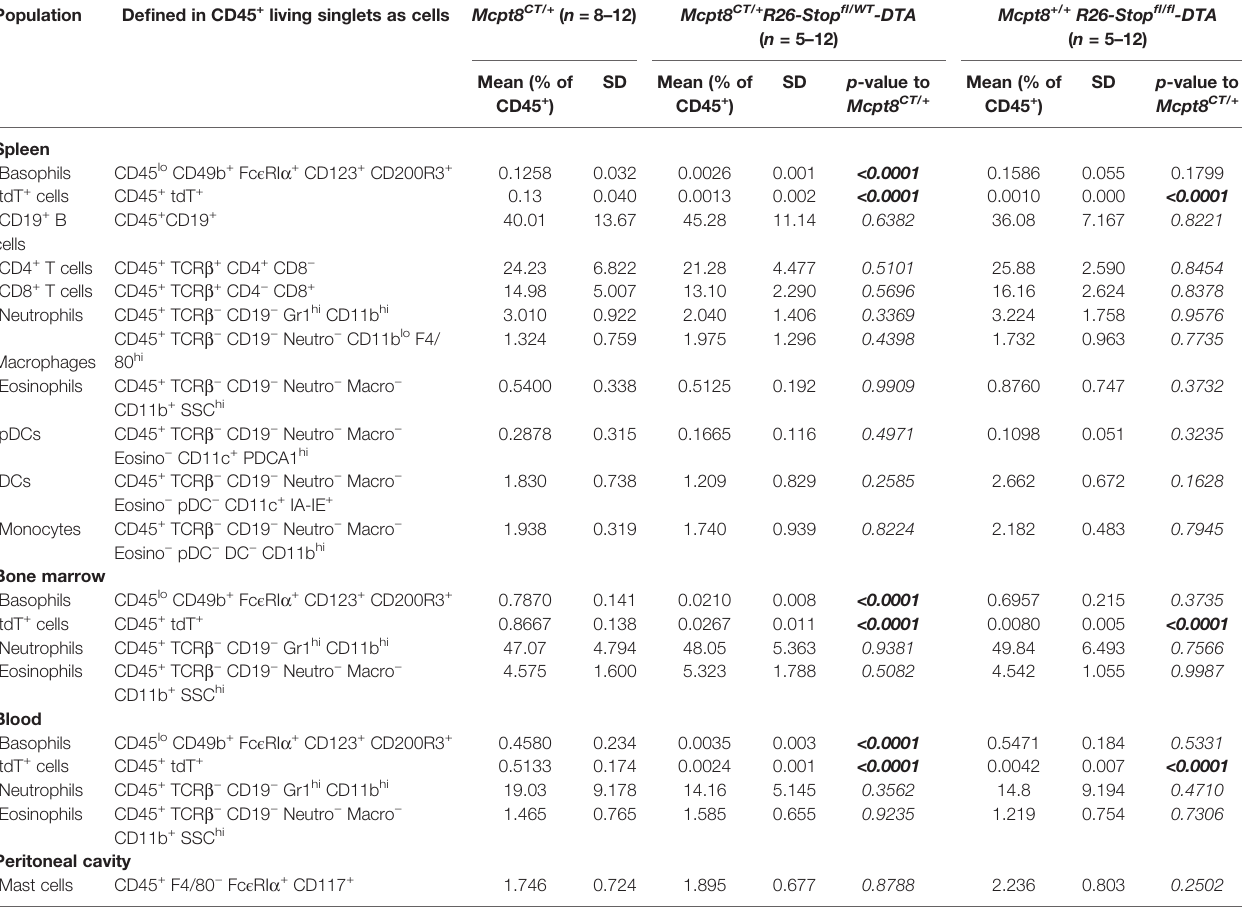
TABLE 2 | Immune cell populations in basophil-de fi cient mice.